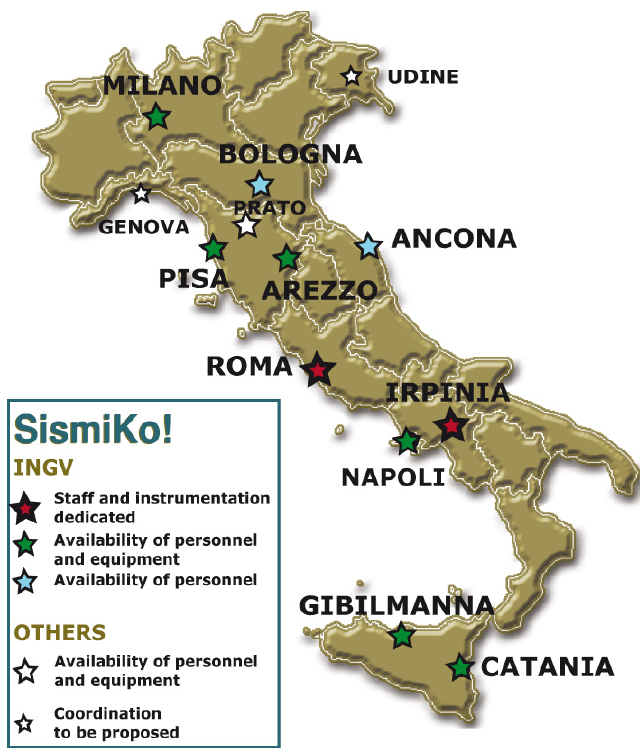
Figure 1. INGV centers in the Italian territory. Differently colored stars, avail- ability of both personnel and instruments or personnel only for emergency network deployments; white stars, other Italian Institutes that generally de- ploy temporary stations (e.g., Prato Ricerche, OGS and Genova